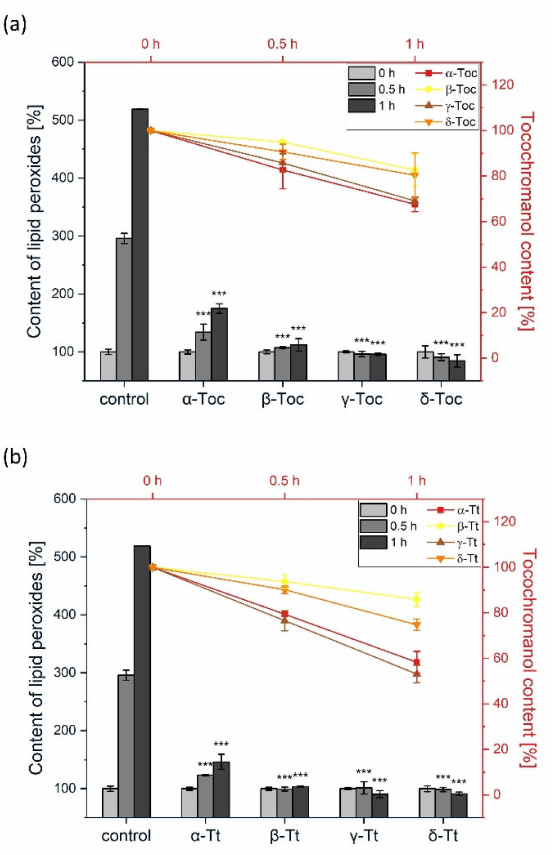
Figure 4. ( a ) The effect of Toc on the rate of the formation of lipid peroxides in plant lipid liposomes initiated by AIPH ( bars ). Time-course of Toc decay during the peroxidation reaction ( lines ). ( b ) The effect of Tt on the rate of the formation of lipid peroxides in plant lipid liposomes initiated by AIPH ( bars ). Time-course of tocotrienol decay during the peroxidation reaction ( lines ). The reactions were conducted at 37 ◦ C. The data are means SEM ( n = 3). Asterisks indicate statistically significant ± differences compared with control at corresponding time point (*** p < 0.001; one-way ANOVA followed by Duncan’s post hoc